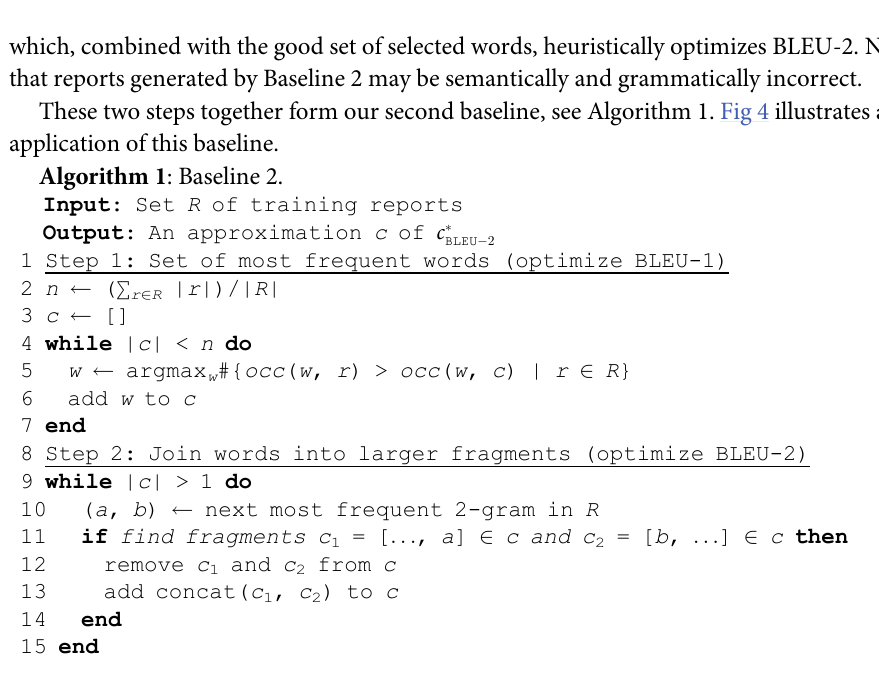
Fig 4. Illustration of unconditioned Baseline 2, which optimizes BLEU-1 and BLEU-2.